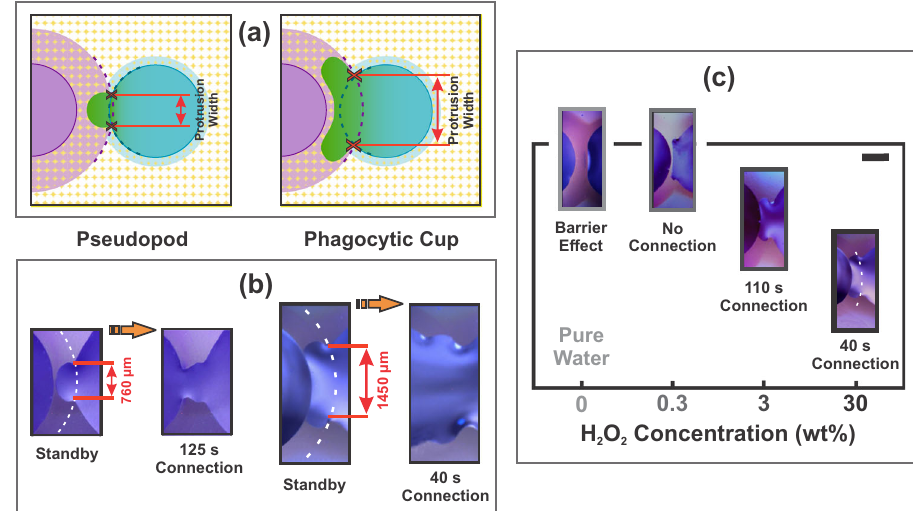
Fig. 5 Programmable interplay of droplets. a Geometric illustration of different protrusion widths achieved as a result of the different overlaps reached by the H 2 O 2 droplets with the annulus of KI droplets. b Pictures just before and after bridging between 30 wt% H 2 O 2 and 1 wt% KI droplets to illustrate the distinct protrusion widths and morphologies. The dashed white superimposed curves mark the extrapolation of the annulus surrounding the KI droplet. Note that a more widened protrusion shape is indeed observed due to a greater crossing between the attacking H 2 O 2 droplet edge (right) and the annular signaling from the KI droplet (left). The time just after droplet coupling indicate the different connection times between the droplets that are linked to the different protrusion widths. c Dependence of the interaction behavior between H 2 O 2 droplets of different concentrations and 1 wt% KI droplets. Insets illustrate the standby stage for the different H 2 O 2 concentrations. Scale bar = 1 mm. A longer time from protrusion nucleation to droplet coupling (connection time) was observed in the case of 3 wt% H 2 O 2 droplet with respect to the 30 wt% H 2 O 2 droplet concentration. The 0.3 wt% H 2 O 2 droplet showed the protrusion generation step but failed to couple. Instead, a barrier effect was found in the case of the water droplet, where the signaling annulus coming from the KI droplet even repelled the total spreading of the water